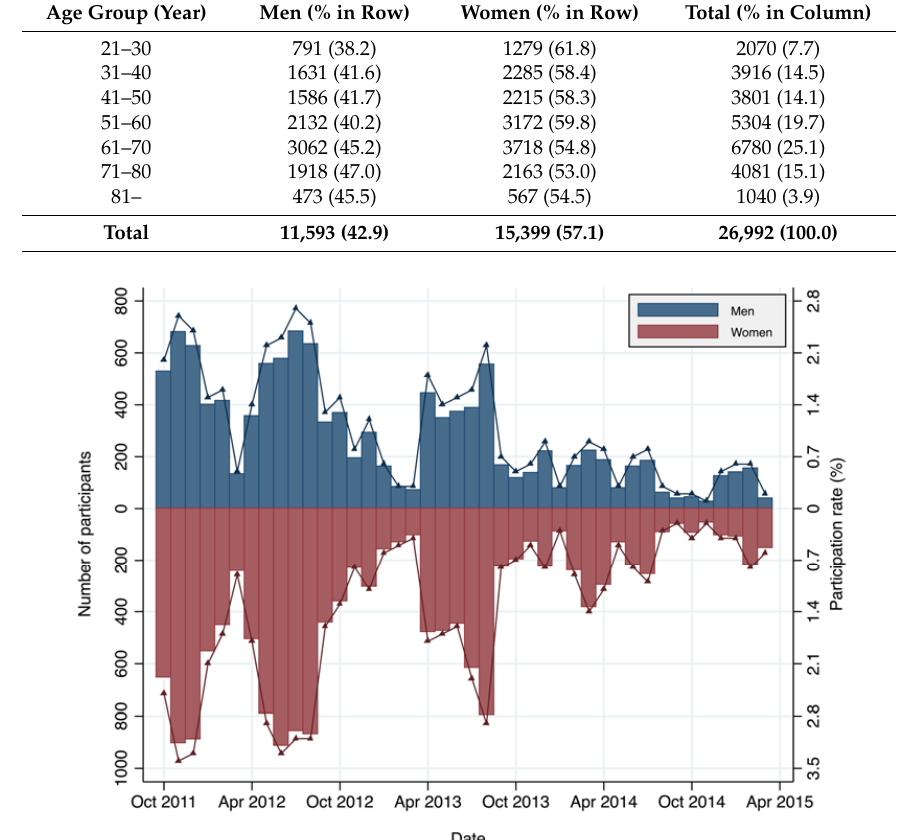
Table 1. Distribution of whole body counter monitoring participants by age group and sex from 1 October 2011 to 31 March 2015.